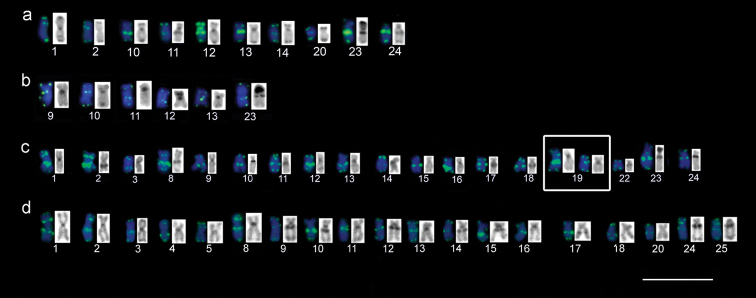
Chromosomal pairs with ITSs in comparison with C-positive (C-banding) heterochromatin aA.
falcirostrisbA.
falcatuscA.
prope
microlepisdA.
microlepis. The pairs are arranged irrespective of the type of chromosome. Scale bar: 10 µm.